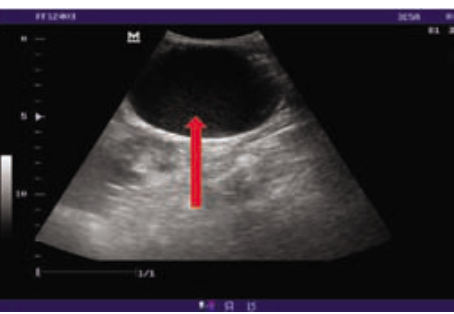
Fig. 1. Haematuria